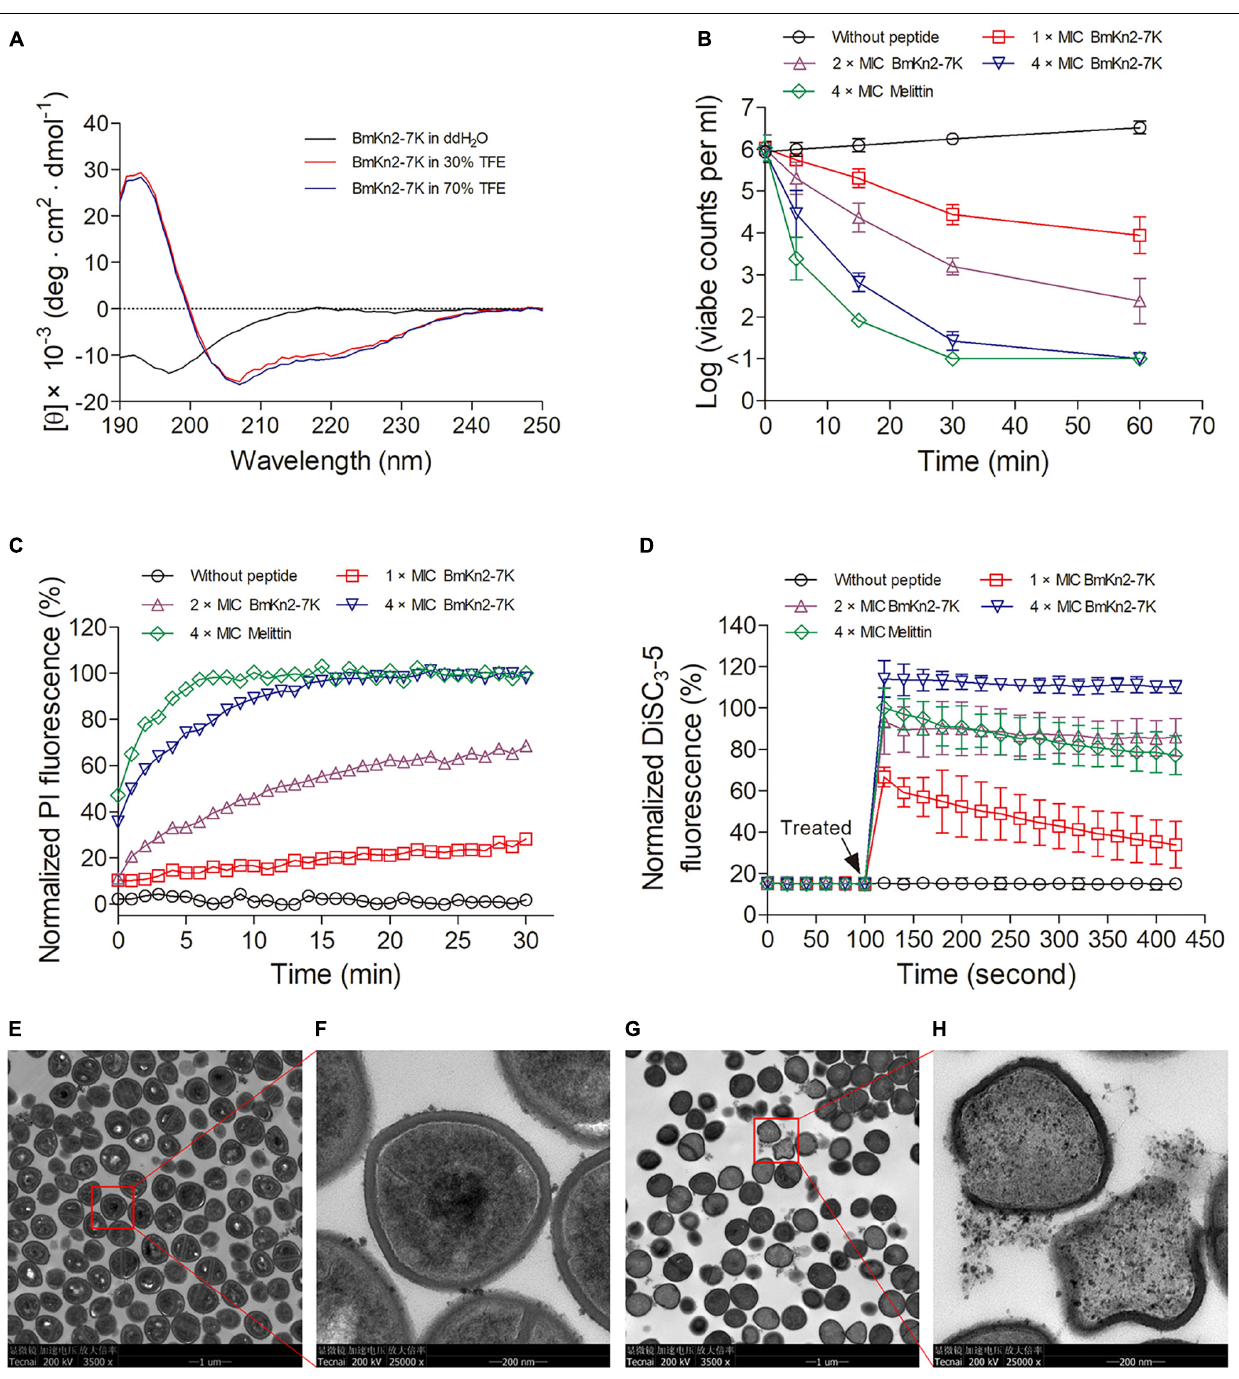
Frontiers in Microbiology |